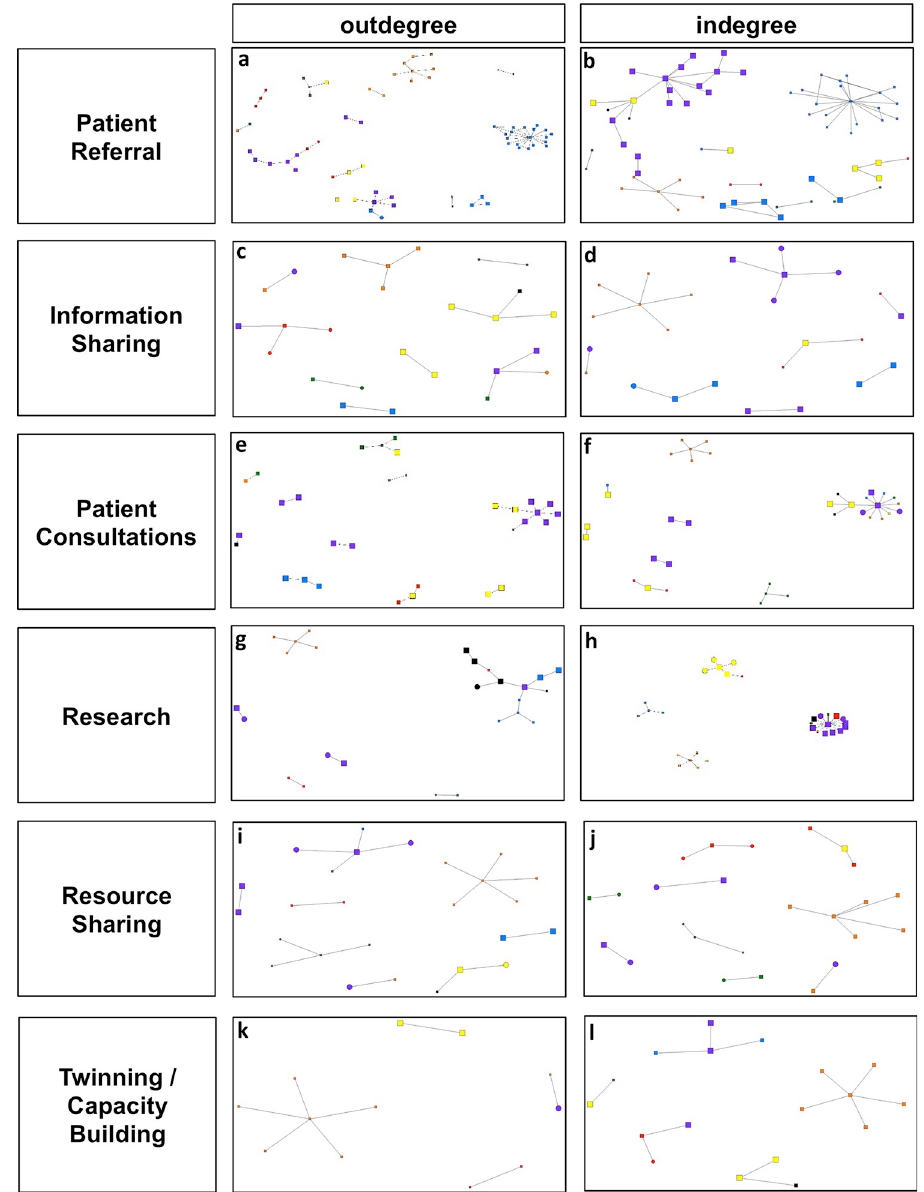
Fig 2. Network diagram for outdegree and indegree collaborative activities. Network diagrams depicting (a) outdegree patient referral, (b) indegree patient referral, (c) outdegree information sharing, (d) indegree information sharing, (e) outdegree information sharing, (f) indegree patient consultation, (g) outdegree patient consultation, (h) indegree research, (i) outdegree research, (j) indegree research sharing, (k) outdegree twining/capacity building and (l) indegree twining/capacity